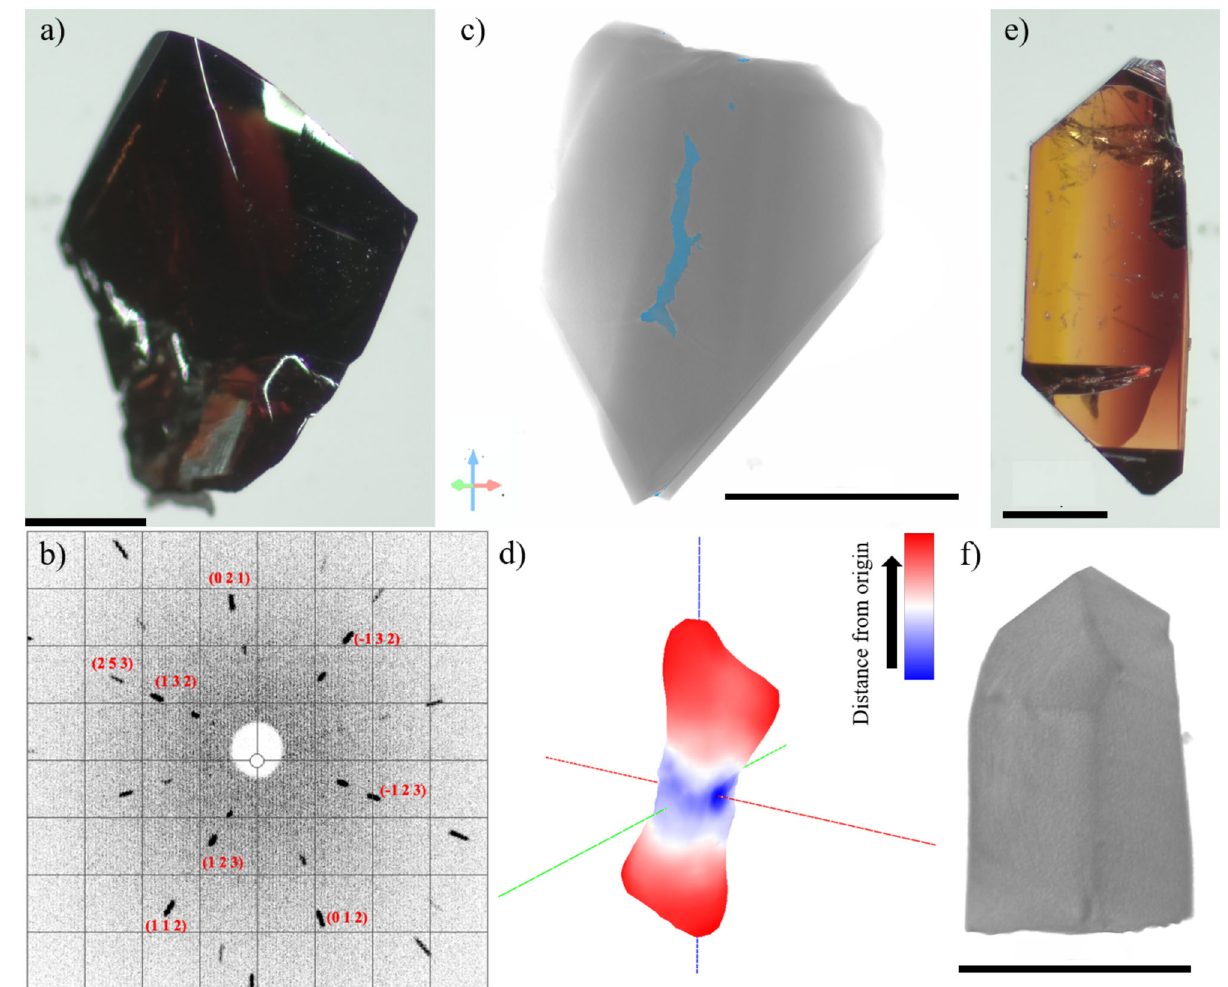
Fig. 4 Voids in r-GeO 2 . a A single crystal of rutile GeO 2 grown using a fl ux with a cooling rate of 3 °C/h. b Laue diffraction image of the crystal along the [011] direction. c A representation of a crystal from the same batch as ( a ) generated from µCT data with voids present (highlighted blue). d A 3D rose diagram of the star volume distribution of the voids. The data was aligned such that the void shows a preferential orientation parallel to the [011] direction of the crystal axis. The image is colored according to the distance from the origin. e A different crystal of rutile GeO 2 grown using a fl ux with a cooling rate of 0.5 °C/h. f A rendering of a crystal from the same batch as ( e ) showing no detectable